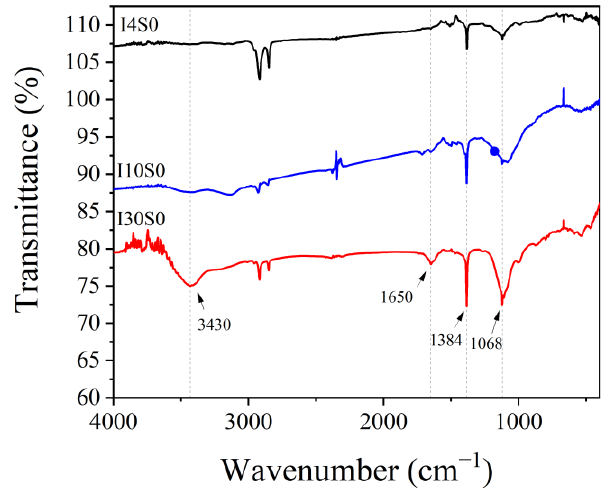
Figure 13. FTIR spectra of specimens recycled from tap water electrolyte.